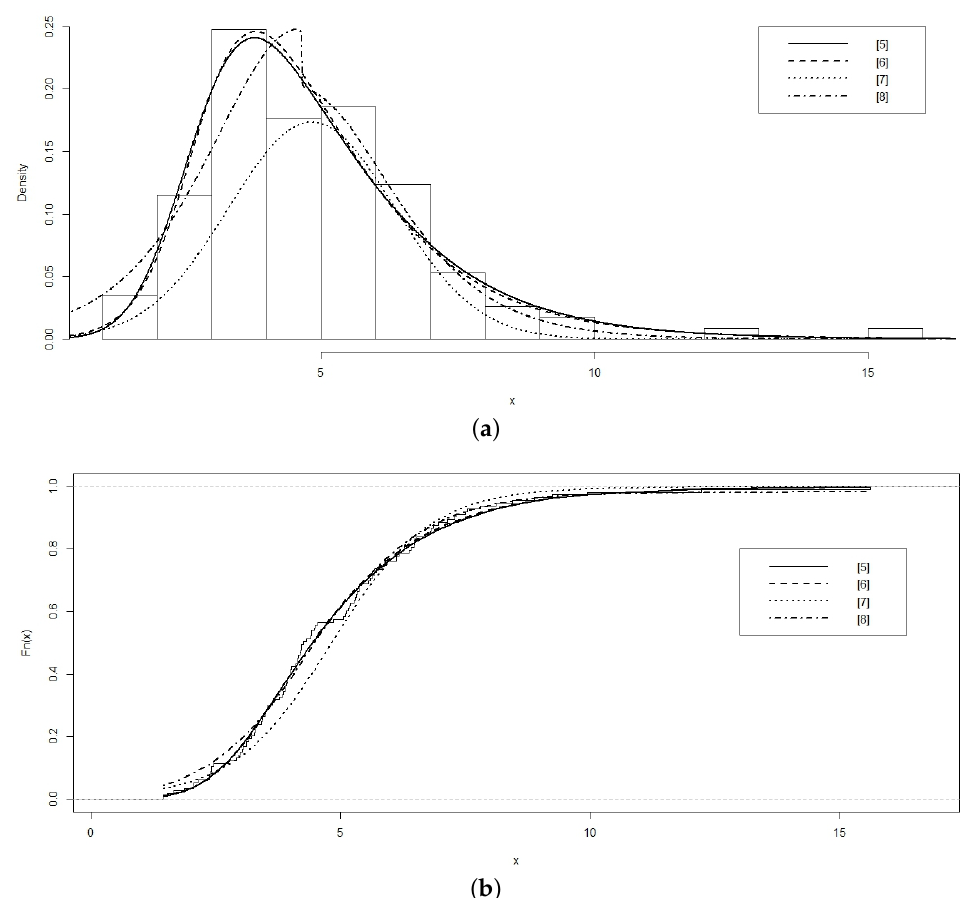
Figure B1. Education data - Fitted Nadarajah and Kotz [6] distributions. [5] Skew Logistic-Normal distribution; [6] Skew Logistic- t distribution; [7] Skew Normal-Logistic distribution; [8] Skew t -Logistic distribution. ( a ) Probability density function; ( b ) Cumulative